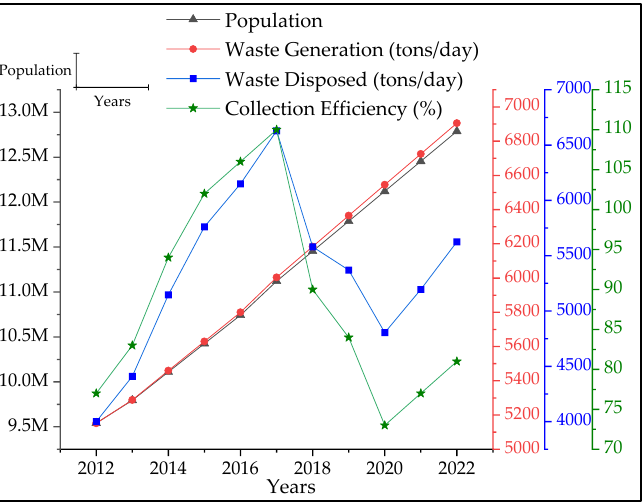
Figure 21. Fluctuation in waste collection efficiency over the period of eleven years .